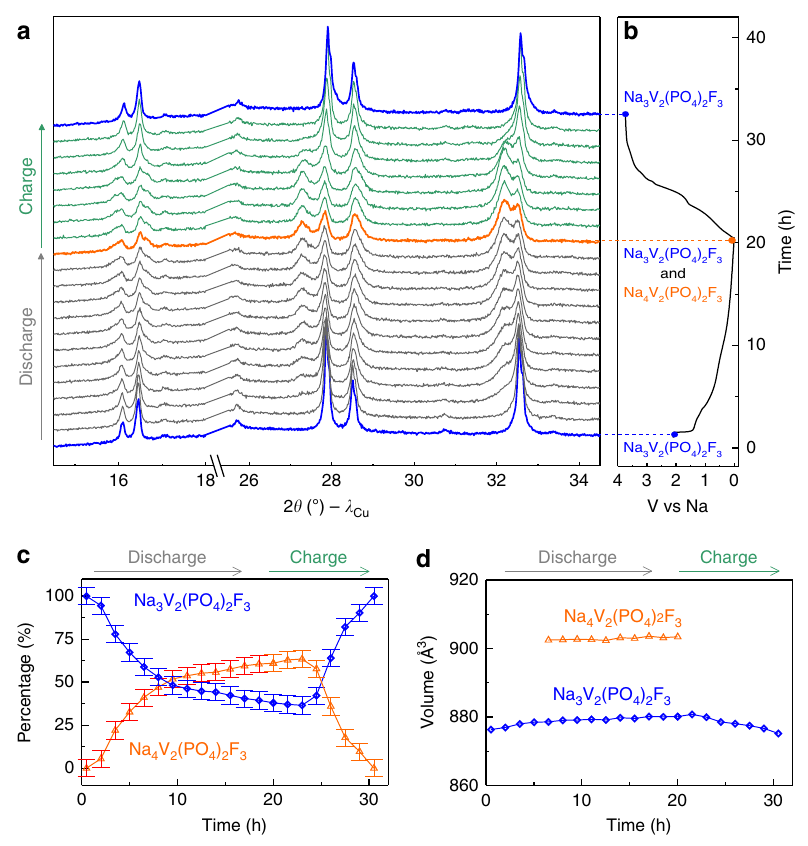
Figure 4 | In situ XRD patterns collected for a Na 3 V 2 (PO 4 ) 2 F 3 /Na cell. XRD patterns ( a ) and the corresponding electrochemical curve ( b ) is shown. The percentage of each phase and their unit cell volumes are shown in c , d , respectively. Error bars represent standard deviation obtained from the Rietveld refinement. Note that the Na 4 V 2 (PO 4 ) 2 F 3 phase mainly forms at the beginning of the process (within the 1.4–0.8V domain) and then the Na-uptake appears self-limiting for reasons explained with the text. For time 4 20h the amount of Na 4 V 2 (PO 4 ) 2 F 3 within the accuracy of the measurements still increases, while the cell is already in its oxidation mode.